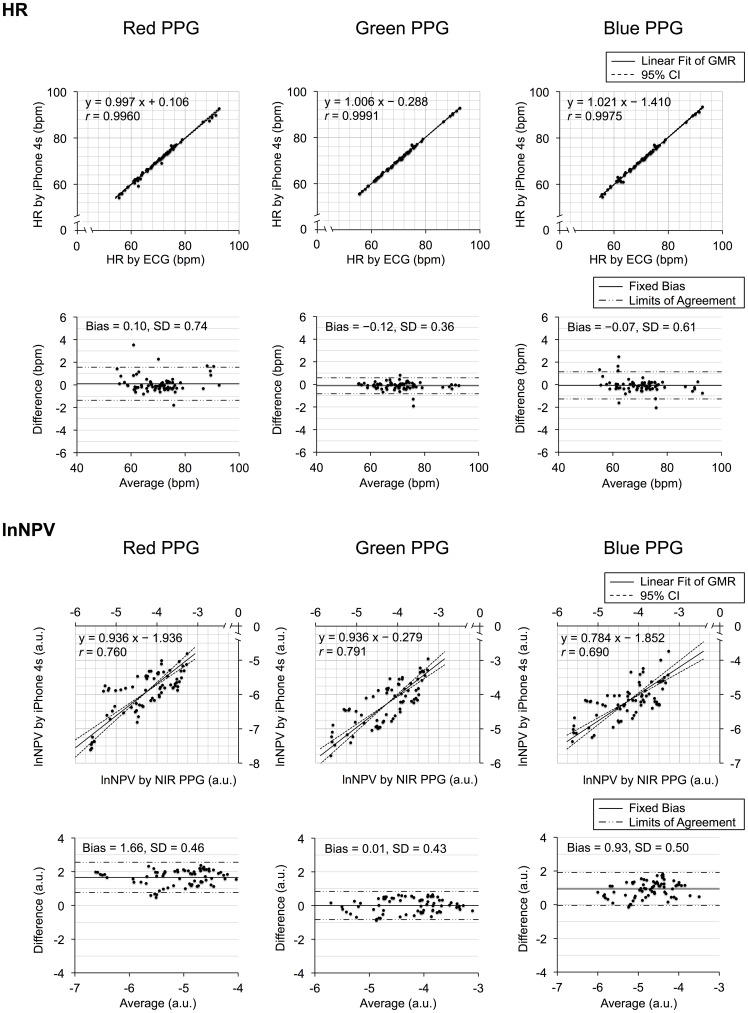
The agreement of HR and lnNPV measured by the smartphone PPG and corresponding references.Each section of heart rate (HR: Top) and log-transformed normalized pulse volume (lnNPV: Bottom) includes the three pairs of scatterplot (Upper) and Bland-Altman plot (Lower) measured by red (Left), green (Center), and blue (Right) light smartphone PPG against those by the corresponding reference devices among all of the 72 data pairs (three conditions × two repetitions × 12 participants). ECG  =  electrocardiography, PPG  =  photoplethysmography, NIR  =  near-infrared, GMR  =  geometric mean regression, bpm  =  beats per minute, and a.u.  =  arbitrary units.